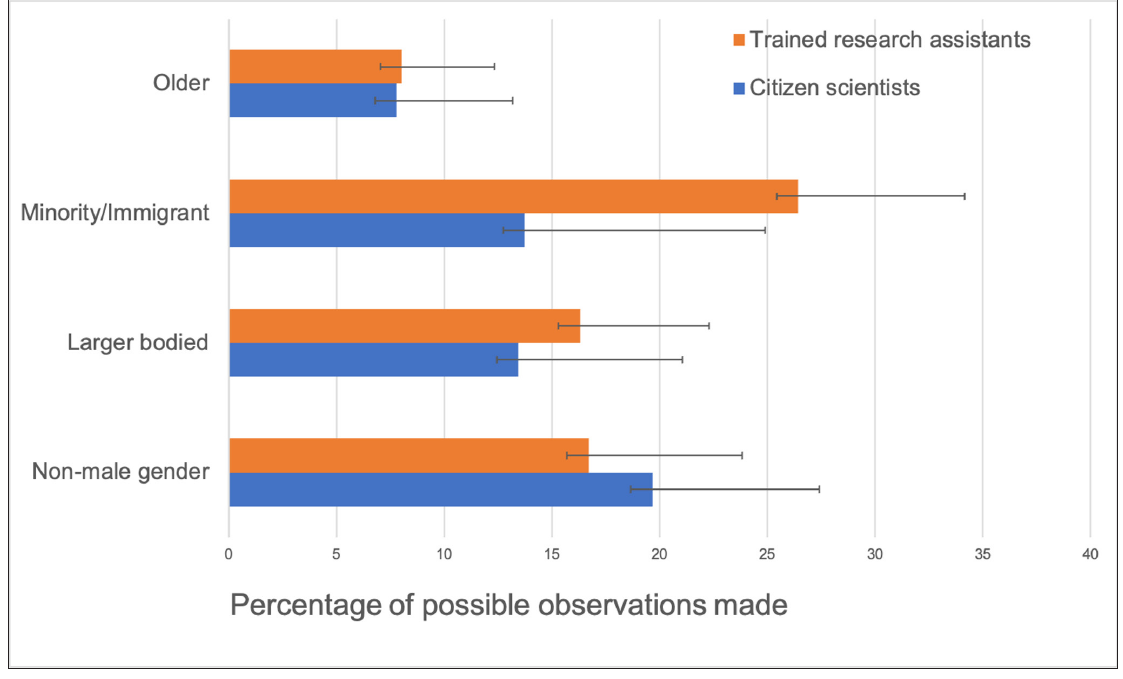
Figure 3 Mean percentage of possible correct observations by exclusion domain for citizen scientists (n = 162) versus trained research assistants (n = 33). The whiskers represent standard